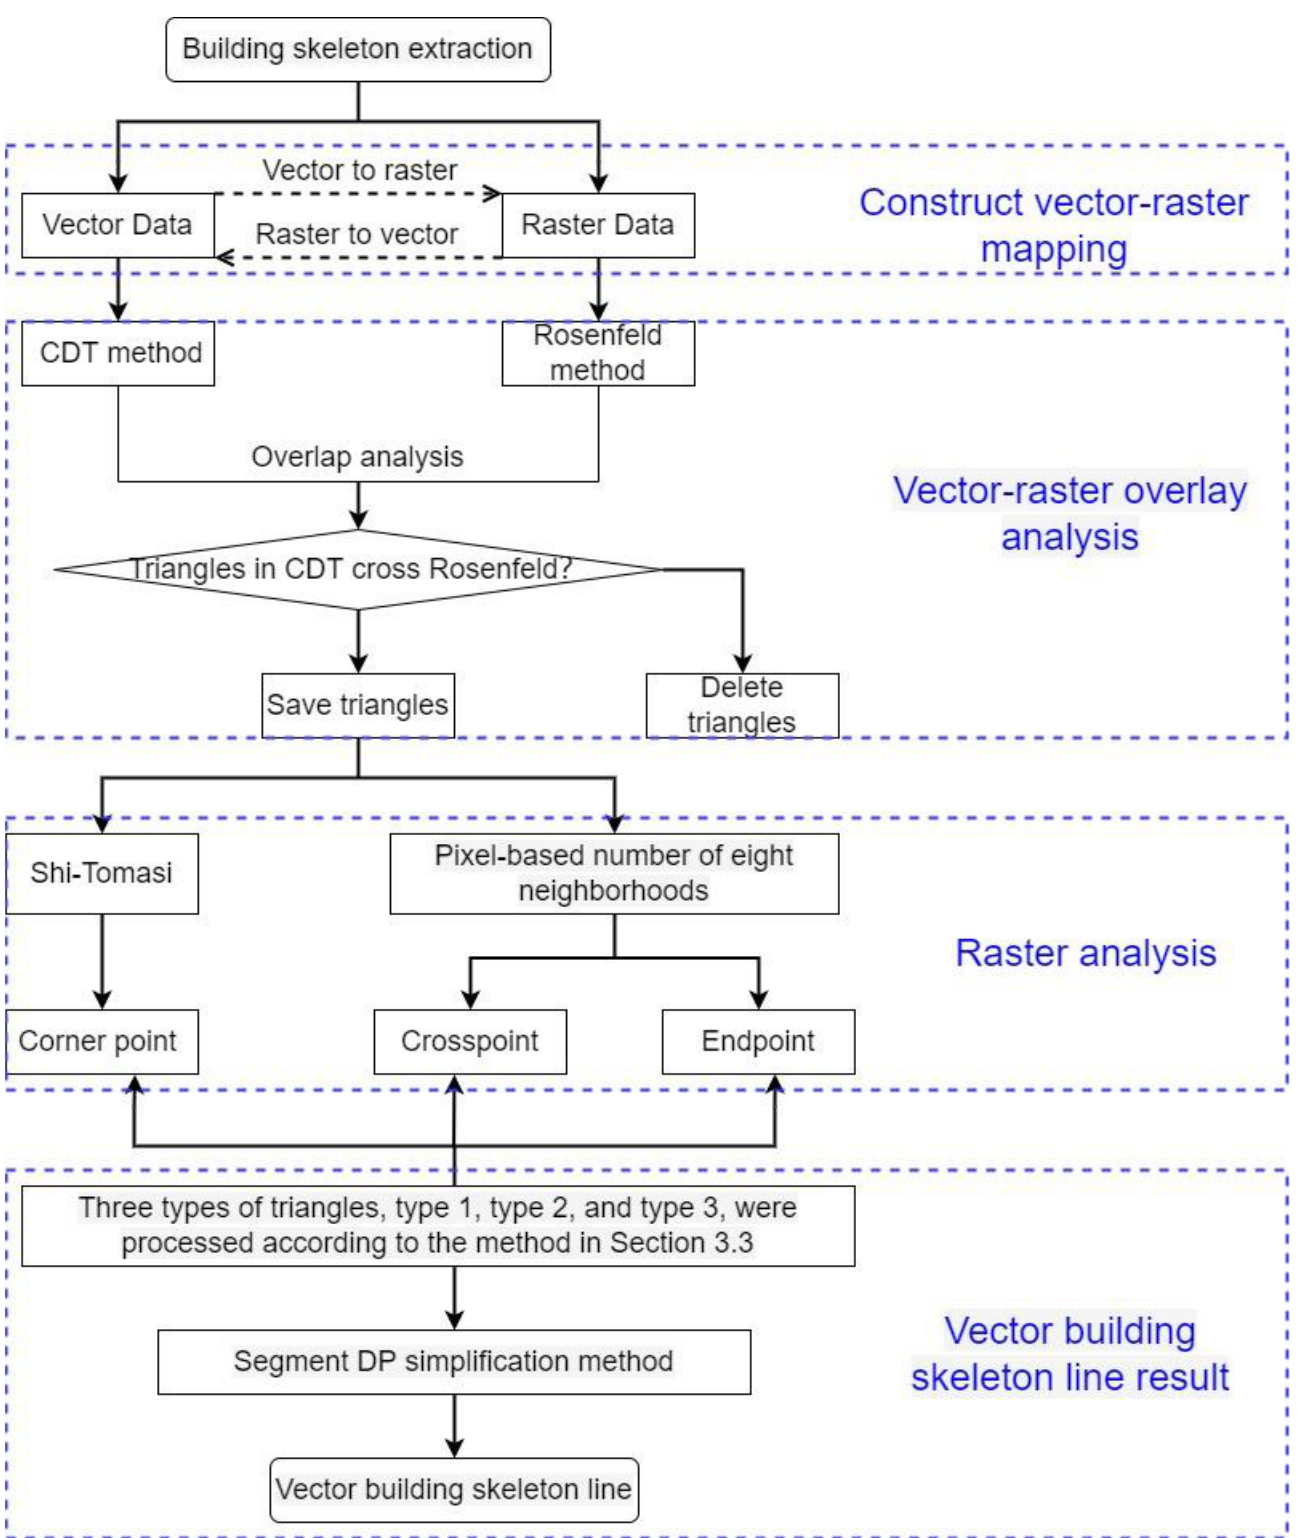
Figure 5. Process flow of building skeleton line extraction.